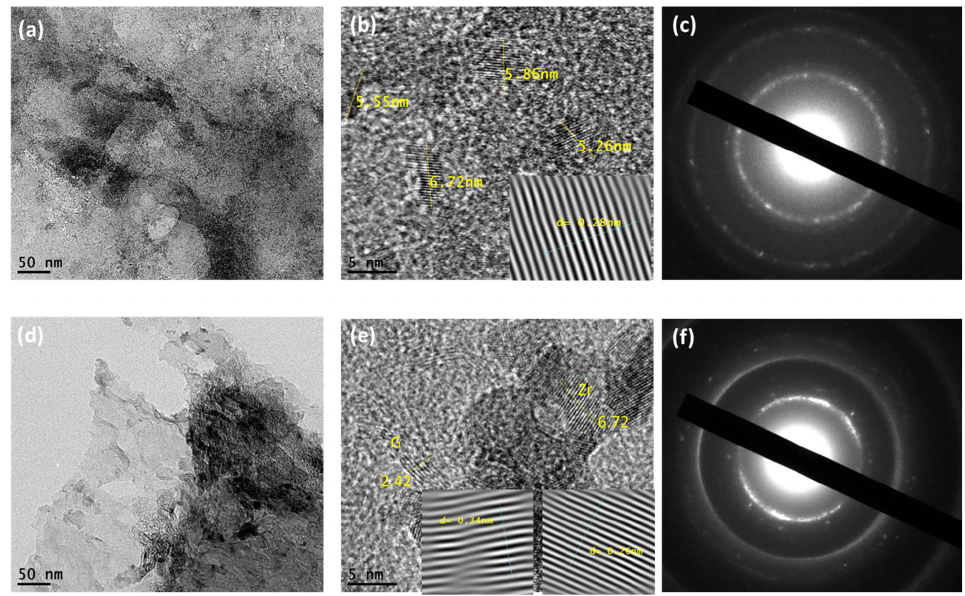
Figure 1. HRTEM, lattice images, and SAED for ( a – c ) ZrO 2 , and ( d – f ) ZrO 2 /G10 samples. The selected area electron diffraction (SAED) pattern exhibited a mixture of crystallographic structures with tetragonal and monoclinic ZrO 2 as a major and minor phase [15], respectively (Figure 1c,f). A series of spots were observable next to these rings that were related to the monoclinic phase of ZrO 2 in agreement with the PDF card 88–2390 (Figure 1c). From the spot of fringe patterns, the contact boundaries between the two compounds could be concluded, confirming the heterojunction connection for the composite (Figure 1f). Moreover, Figure 2 illustrates the EDX mapping for oxygen, zirconium, and carbon for ZrO 2 , and ZrO 2 /G10 samples. Figure 2a shows the qualitative distribution of Zr and O elements on a 200 nm scale of ZrO 2 . The Zr and O are widely distributed and not aggregated inside the composite. It is observed that the O level is higher than Zr, as shown later in EXD spectra.